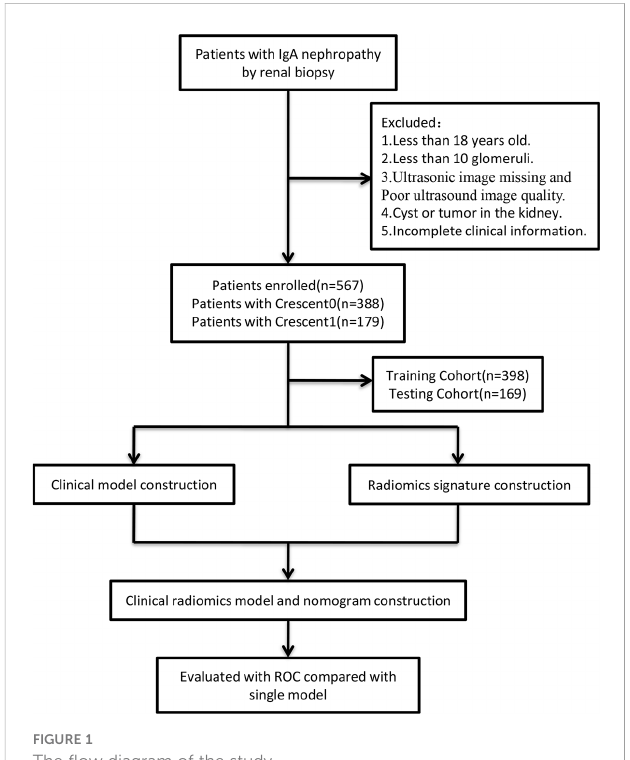
FIGURE 1 The fl ow diagram of the